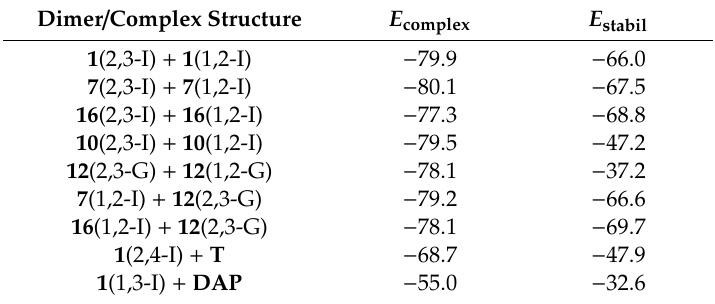
The calculated complexation and stabilisation energies (kJ / mol) of isocytosine and guanine